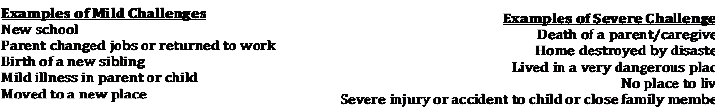
Figure 2. The Child Life Challenges Scale (paper-pencil version).